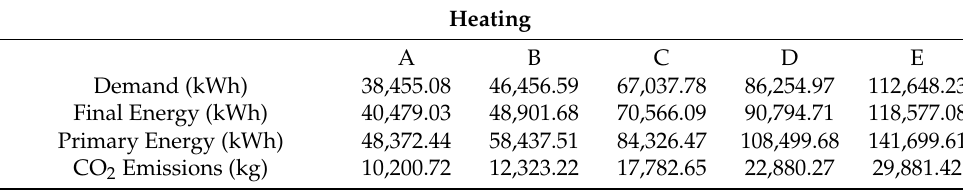
Table 7. Results Obtained with the Initial Scenario.